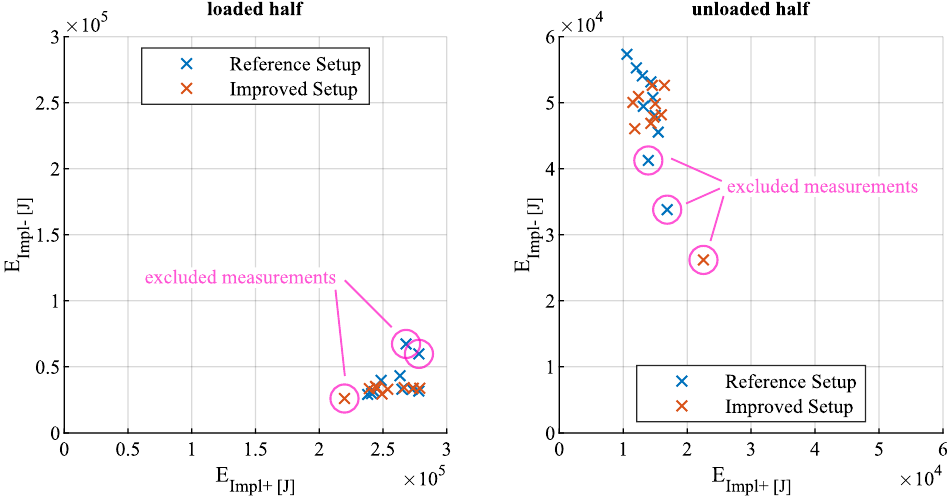
Figure 7. Plot of implemented energies according to Equations (8) and (9) for an exemplary loading cycle (for details about the cycle, see “truck loading with simultaneous movement” in Section 5); not considered outliers are marked in